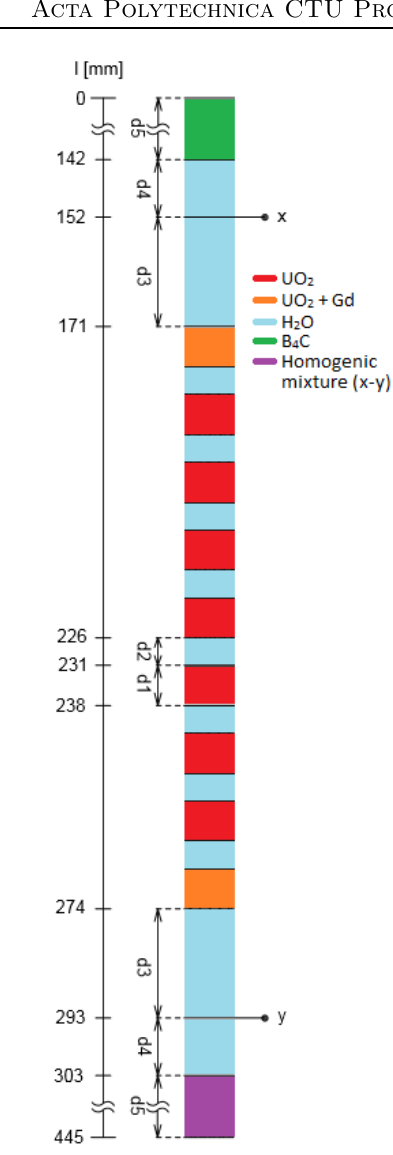
Figure 2. Graphical representation of investigated nuclear reactor core.